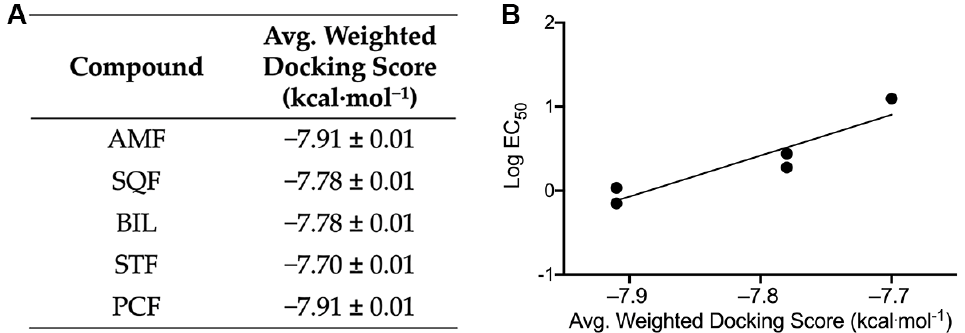
Figure 3. Results from docking biflavonoids to A β 42 (PDB: 2NAO). ( A ) Average weighted docking scores ± S.E.M. for the most negative binding cluster for each biflavonoid calculated from the Au- toDock Vina scoring function via the PyRx interface. Simulations were performed with A β 42 in the presence of amentoflavone (AMF), sequoiaflavone (SQF), bilobetin (BIL), sotetsuflavone (STF), and podocarpusflavone (PCF). ( B ) Experimental EC 50 values plotted against the average weighted AutoDock Vina docking scores for each biflavonoid cluster bound to the A β fibril showing a posi- tive correlation (R 2 : 0.866, p = 0.022).